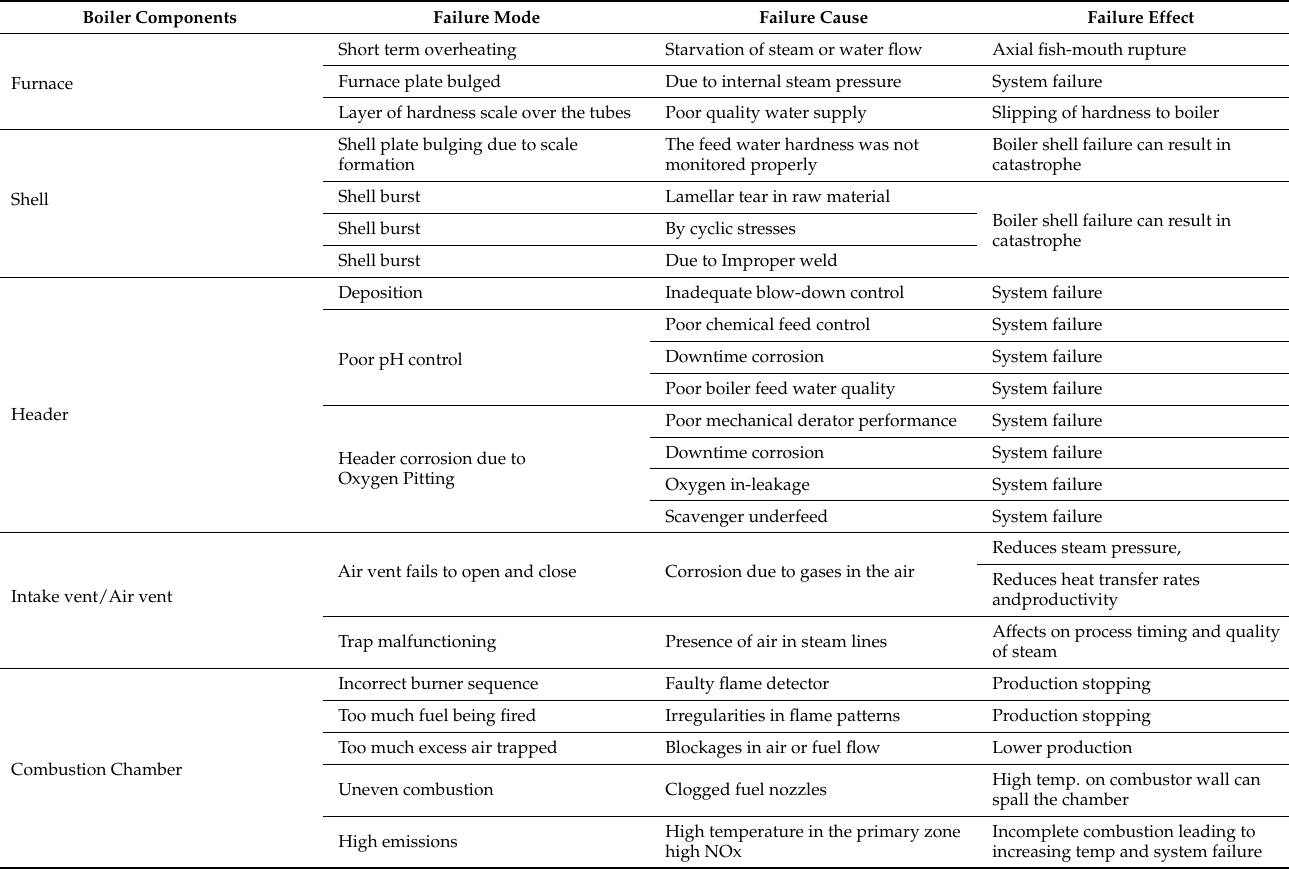
Table A1. Failure modes, Causes and Effects of the selected components of the boiler